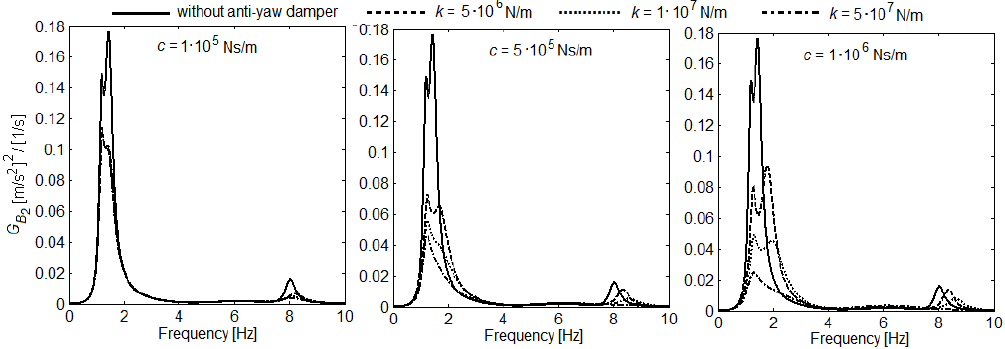
Figure 5. Influence of the damping and the anti-yaw damper stiffness upon the power spectral density of the carbodyaccelerationagainst the rear bogie.